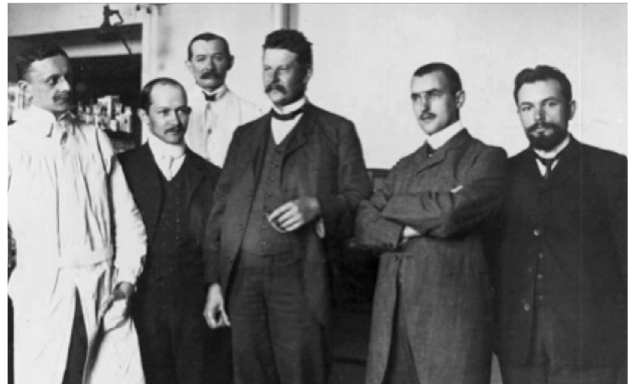
Fig. 2: Otto Appel (fourth from the left) and co-workers at the Botanical Laboratory in Berlin, about 1908 (image: archive of the Julius Kühn